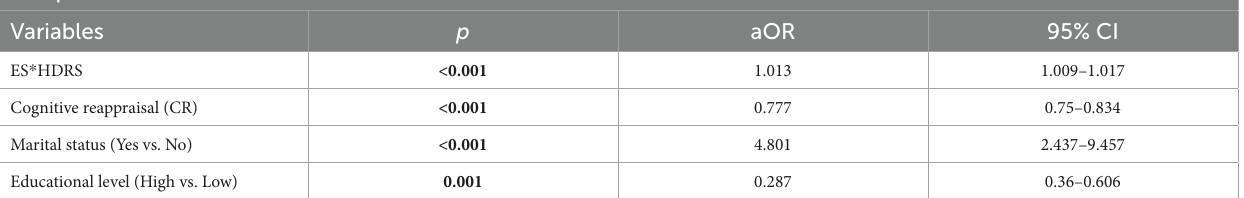
TABLE 4 Adjusted odds ratios with their 95% confidence intervals from the moderated logistic regression of ischemic stroke among cases and control. Model 1: Moderated logistic regression taking the presence vs. absence of ischemic stroke as the dependent variable and taking depression, cognitive reappraisal, expressive suppression, CR * depression and ES * depression as independent